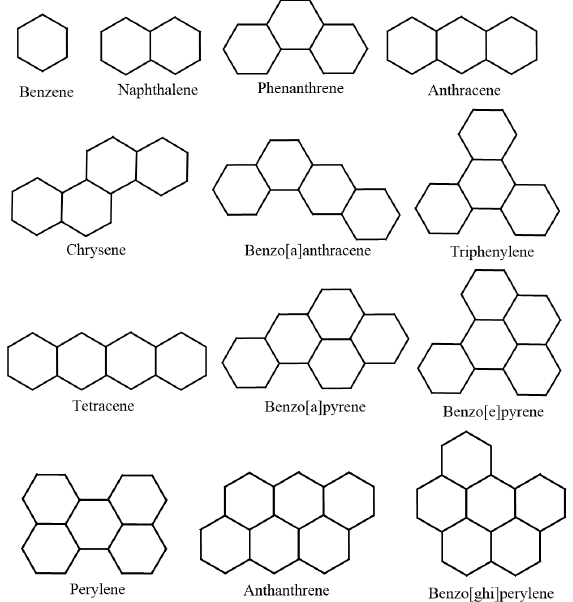
Figure 2. The 22 lower benzenoid hydrocarbons. Contd.